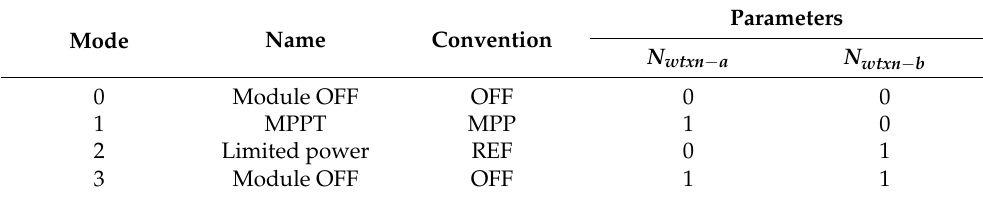
Table 2. Operation modes of wind generators.